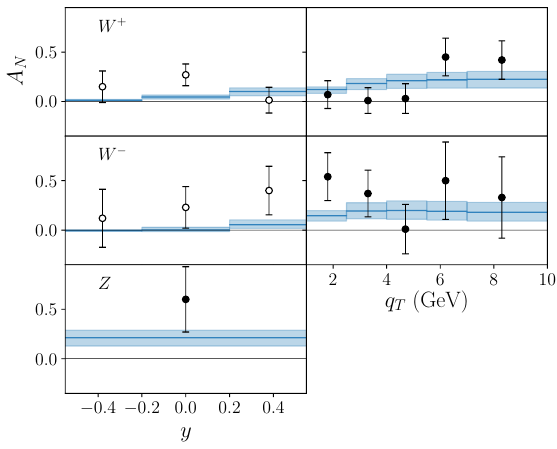
Figure 12. Description of the transverse single-spin asymmetry data [43] for W ± and Z boson production measured by STAR in polarized proton-proton collisions at the data as a function of y for W ± and Z , the right column, the data as a functions of q W ± . Solid (open) symbols data used (not used) in the fit. Blue line is the CF and the blue box is 68%CI of the fit of the data and prediction for the data not used in the